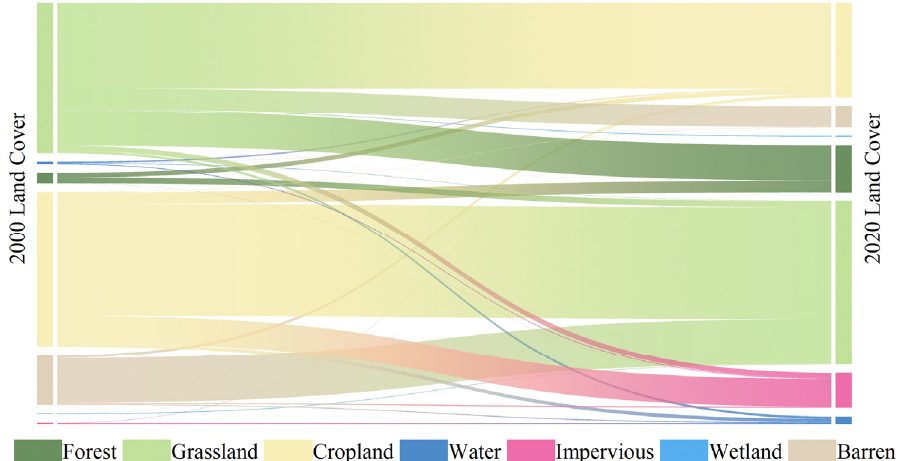
Figure 9. LUCC of the Yellow River basin from 2000 to 2020. We choose the Sankey picture as the visualization of LUCC. The Sankey picture represents a visual result of energy flow. Here, the total area of the study area is taken as an energy flow, and its value does not change between 2000 and 2020. Different land cover types changed during this period. The curve from left to right represents the flow direction of land use type, from type A to type B. The width of the curve represents the area of LUCC. Table 2. LUCC and its impact on NEP in the Yellow River basin from 2000 to